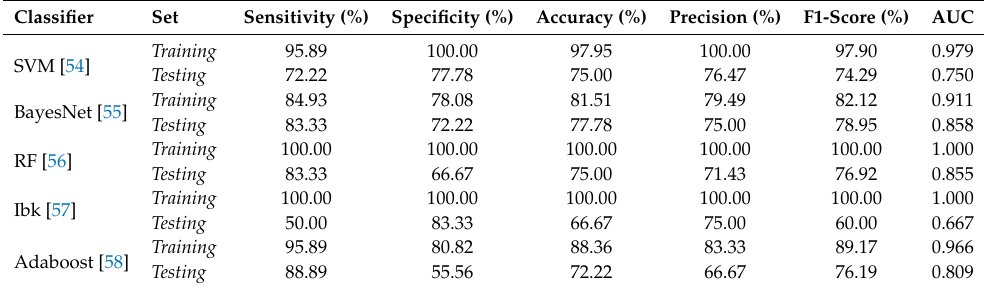
Table 2. Results obtained considering poisoned voice signals in the training and testing sets ( scenario 2 ). Classifier